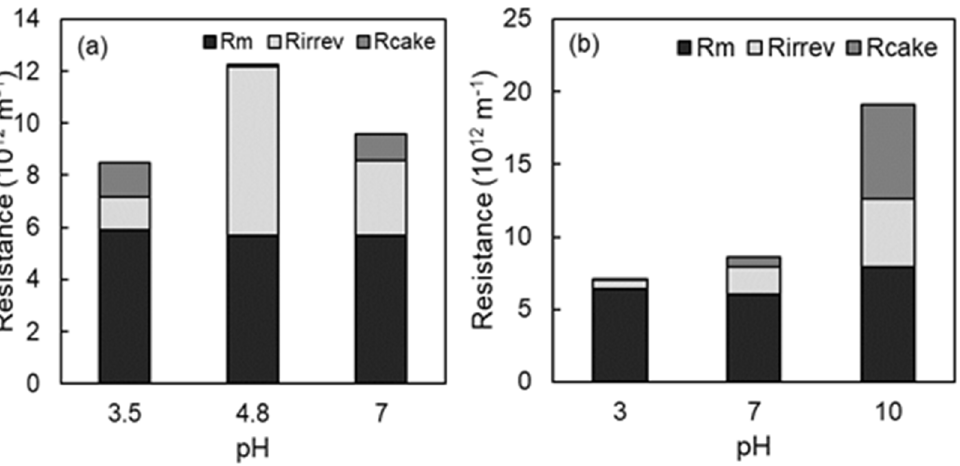
Figure 8. Effect of pH on PVP-ZrO 2 membrane fouling resistances ( R cake and R irrev ) filtration of ( a ) BSA and ( b ) Lys solutions at the ionic strength of 0.1 M ( R m —membrane resistance).